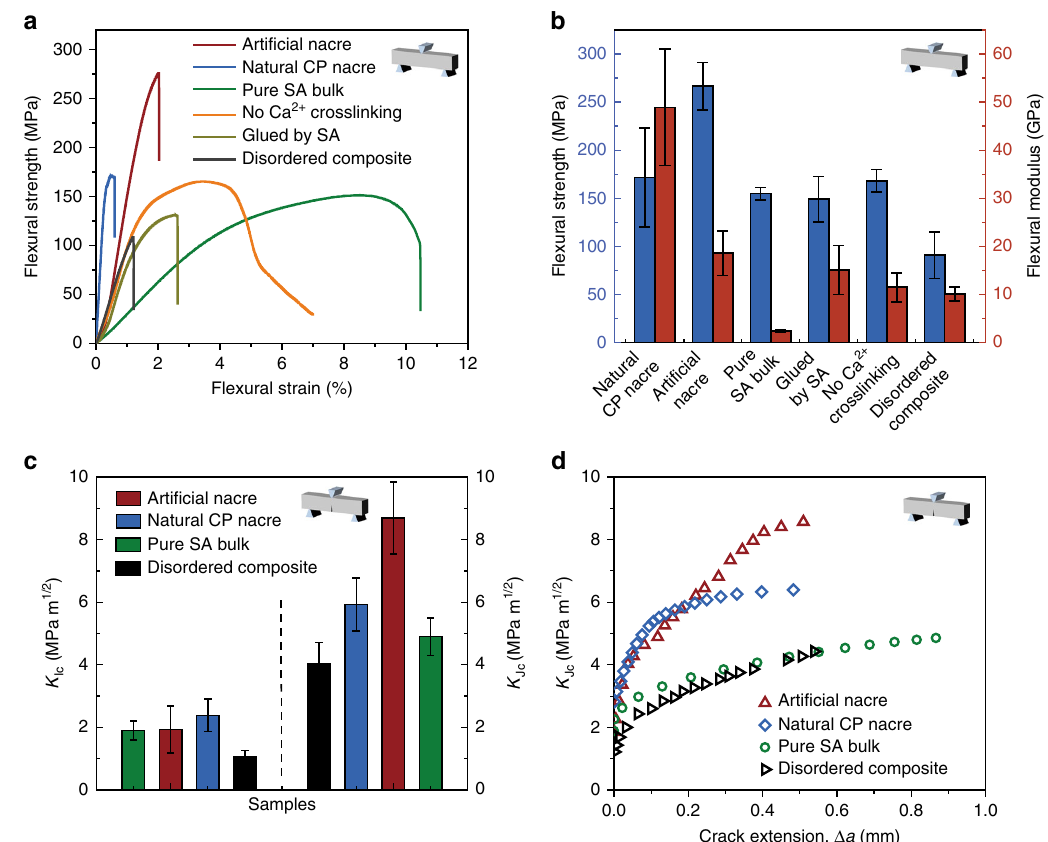
Fig. 2 Mechanical properties of as-fabricated bulk arti fi cial nacre. a Flexural stress – strain curves of the arti fi cial nacre fabricated with different synthetic conditions, natural Cristaria plicata (CP) nacre, pure SA bulk, and disordered composite. b Comparison of fl exural strength and stiffness of the arti fi cial nacre fabricated with different synthetic conditions with natural CP nacre, pure SA bulk, and disordered composite. c Fracture toughness for crack initiation ( K Ic ) and stable crack propagation ( K Jc ) of the bulk arti fi cial nacre compared to natural CP nacre, pure SA bulk, and disordered composite. d Crack-resistance curves (R-curves) showing the resistance to fracture in terms of the stress intensity, K Jc , as a function of crack extension, Δ a , for the bulk arti fi cial nacre, natural CP nacre, pure SA bulk, and disordered composite. All the error bars represent the s.d. of at least six replicate